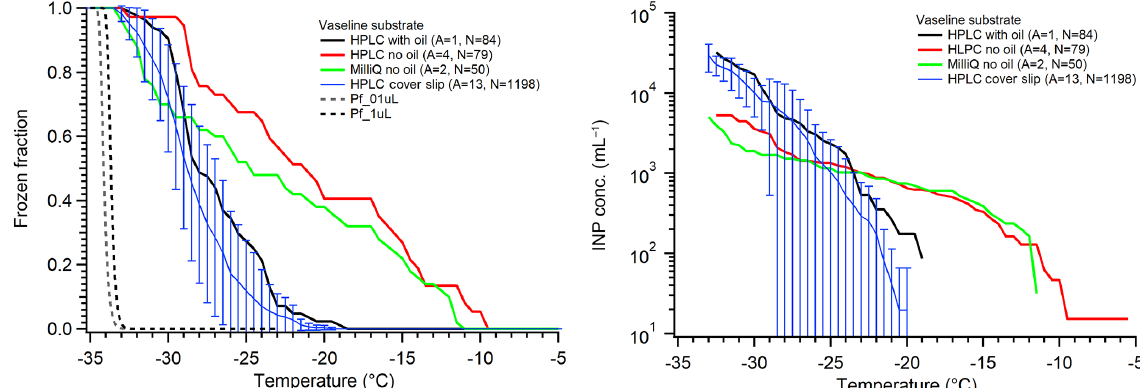
Figure 7. Pure water droplet experiments on a Vaseline-coated substrate, following Fig. 5. The HPLC water using silanized cover slip data in blue are displayed for comparison, as are the data from the hydrophobic cover slip using small droplets (Fig. 5, blue). The data from replicate arrays for Vaseline are combined as described in Sect. 2 and thus no error bars are determined for these. Three sets of experiments on Vaseline are shown: black is small droplets (0.1µL) of HPLC filtered water in oil, red is large droplets (1.0µL) without oil, and green is large droplets of MilliQ water without oil. The parentheses next to each legend entry contains the number of arrays of droplets ( A ) and the total number of droplets across all arrays ( N ). The gray and black dashed lines indicate the theoretical homogeneous freezing curve of 0.1 and 1µL droplets, respectively, using the parameterization of Koop and Murray